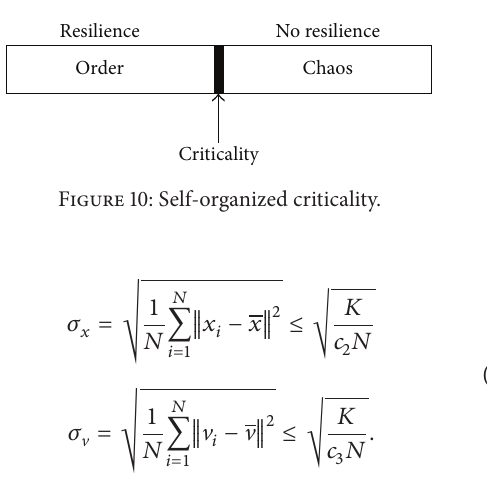
Figure 11: There is resilience within SOC/number 1.